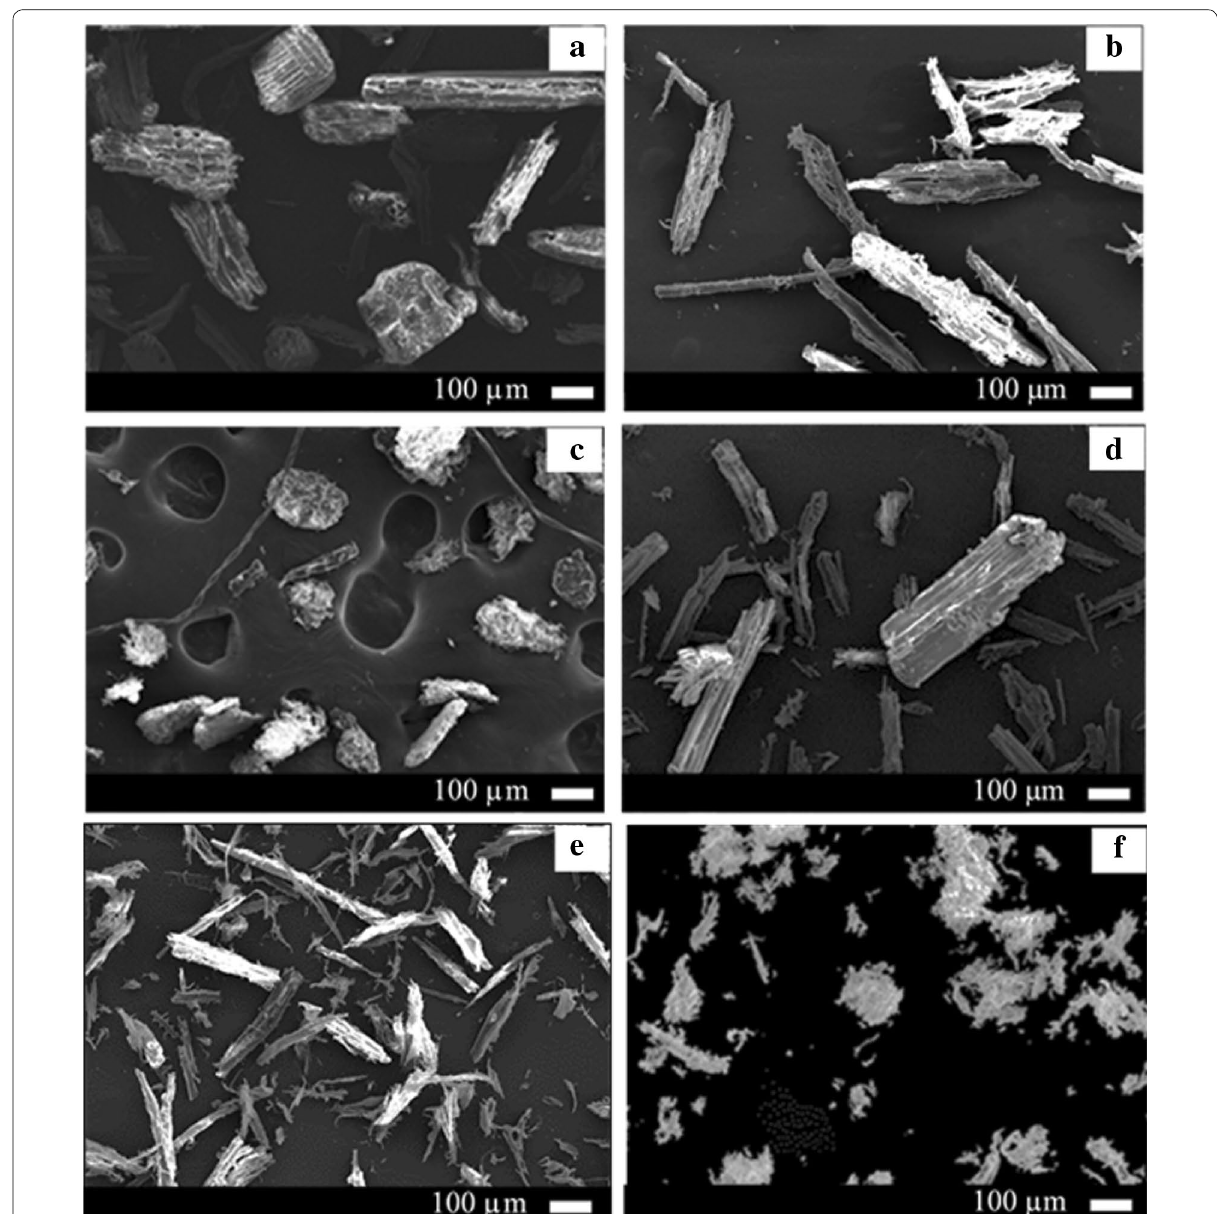
Fig. 4 The SEM image of WF. Heat drying condition: a 0 min, b 30 min and c 120 min of wet milling time. Freeze-drying condition: d 0 min, e 30 min and f 120 min of wet milling